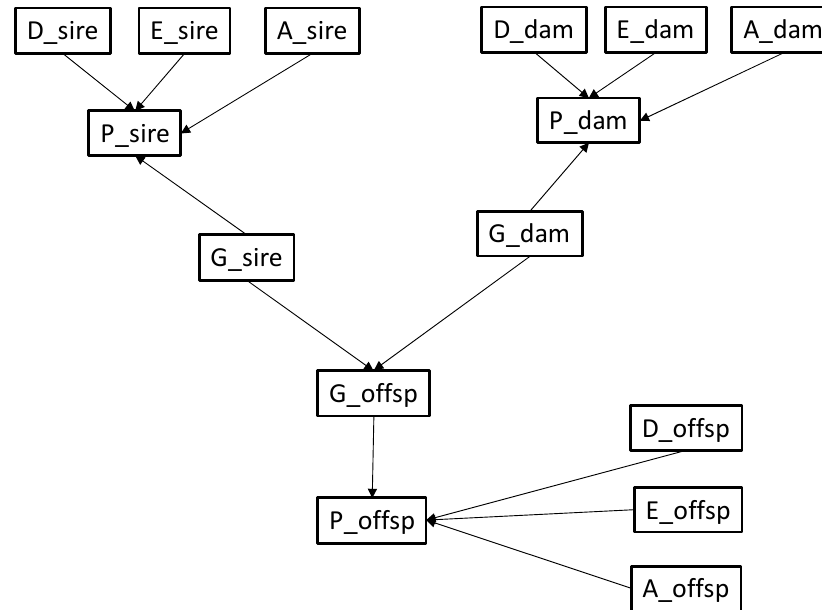
Figure 1. Representation of the nodes and arcs of the network.